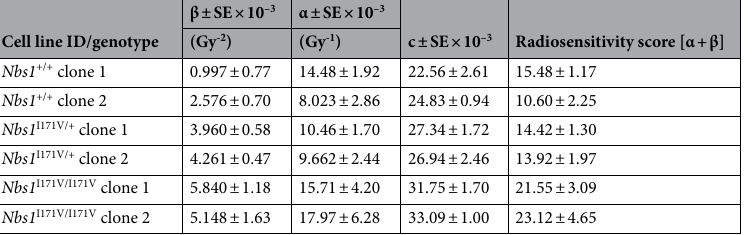
Table 4. Radiosensitivity coefficients (α, β, c, and α + β) in Nbs1 I171V variant knock-in MEFs. α, β, and c coefficients were extracted from dose–response calibration curves in CBMN assay using Cabas software. Relative capacity to repair DNA after acute γ-irradiation was assessed at a dose of 1